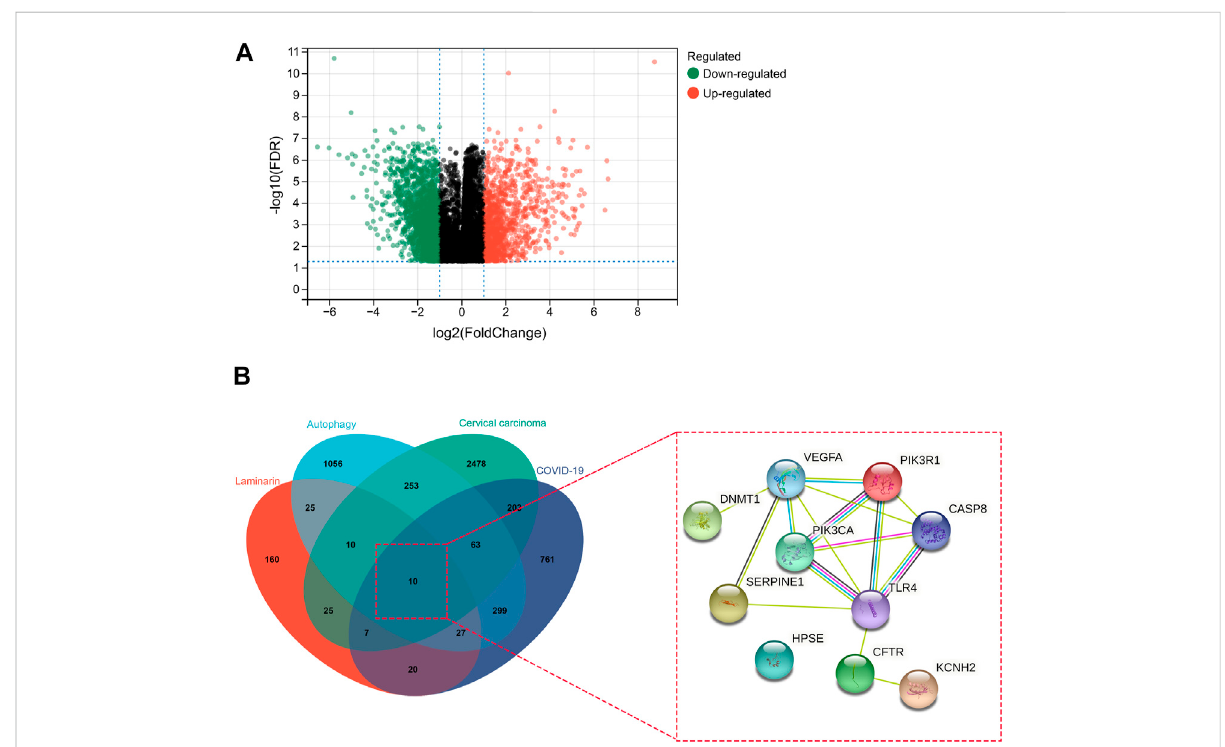
FIGURE 1 Identi fi cationoflaminarin ’ stargetsagainstcervicalcarcinomaandCOVID-19throughautophagy. (A) Volcanoplotshowedthedifferentialgene expression in cervical carcinoma. Genes with |log 2 fold change| > 1 and − log 10 p -value > 1.3 were considered differentially expressed genes. Green dots represented downregulated genes, and red dots represented upregulated genes. (B) Left panel: Venn diagram showed the number of overlapped laminarin-, COVID-19-, cervical carcinoma-, and autophagy-associated genes. Right panel: protein – protein interaction of the laminarin-, COVID-19-, cervical carcinoma-, and autophagy-associated